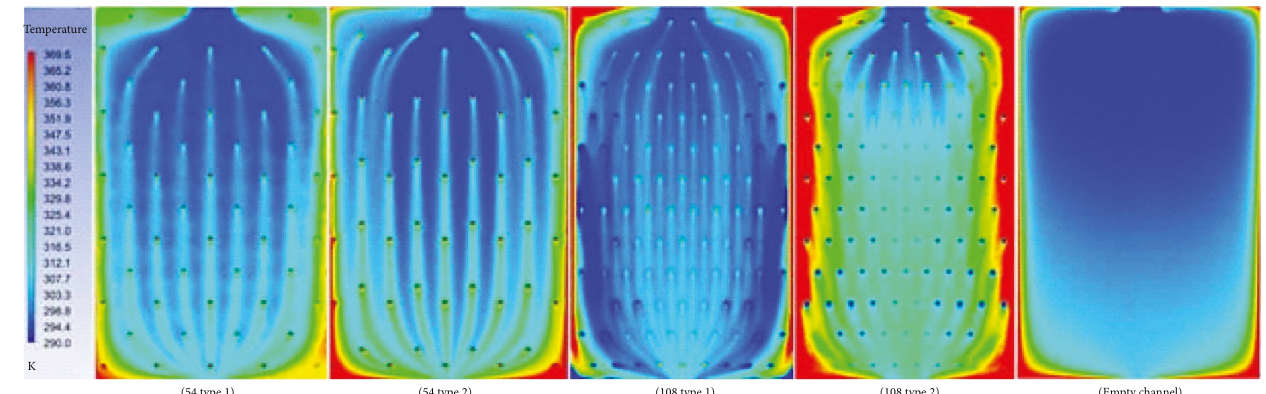
Figure 18: Temperature contours at 3.9m/s.